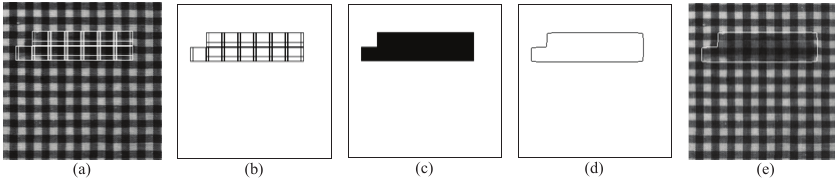
Figure 8. Illustration of defect fusion for the method based on chi-square histogram distance: (a) Boundaries of the defective blocks identified from each cropped image shown superimposed on the original defective image; (b) Boundaries of the defective blocks shown separately on plain background; (c) Result of morphological filling; (d) Canny edge detection; (e) Identified edges shown superimposed on the original defective image using white